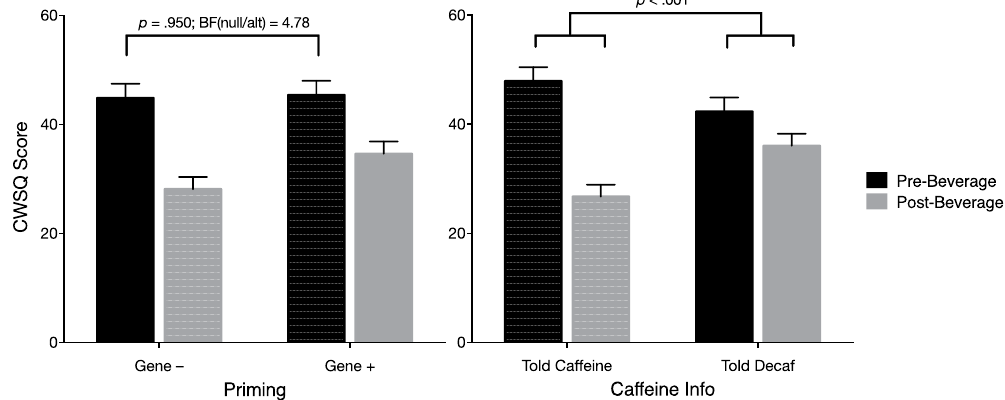
Figure 3. Effect of interaction between Time and Priming (left) and Time and Caffeine Information (right) on Caffeine Withdrawal. Error bars indicate standard